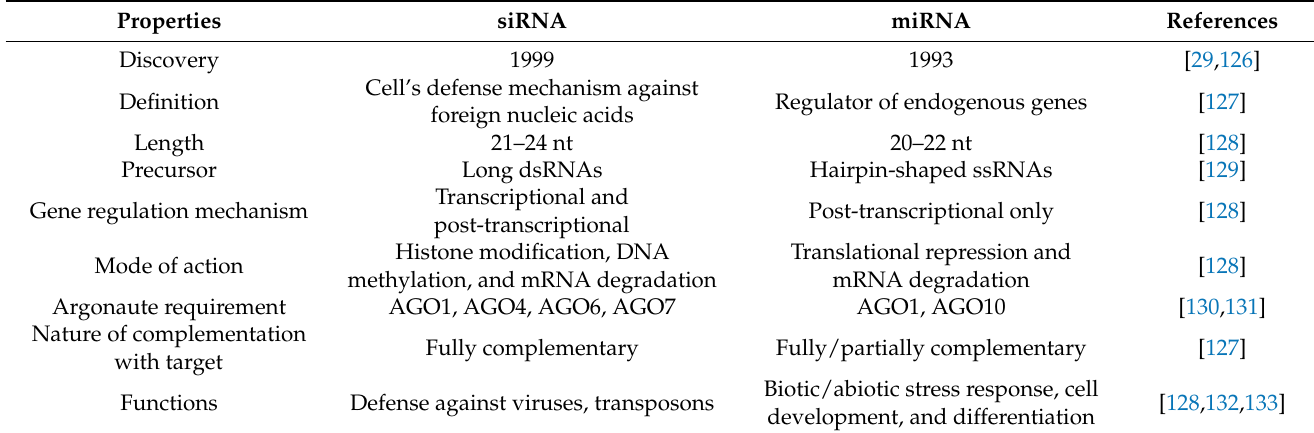
Figure 3. RNA Polymerase II (Pol II) transcribes MIR (micro-RNA) genes and forms stem–loop structure by folding to form pri-miRNAs. These are processed by DCL1 either in a “base-to-loop” or “loop-to-base” track. Small RNA methyltransferase HEN1 methylates the newly formed miRNA/miRNA*duplexes. RISC takes place either in the nucleus or cytoplasm. The basic mode of action of miRNAs (gene silencing) takes place via target cleavage or translation inhibition.